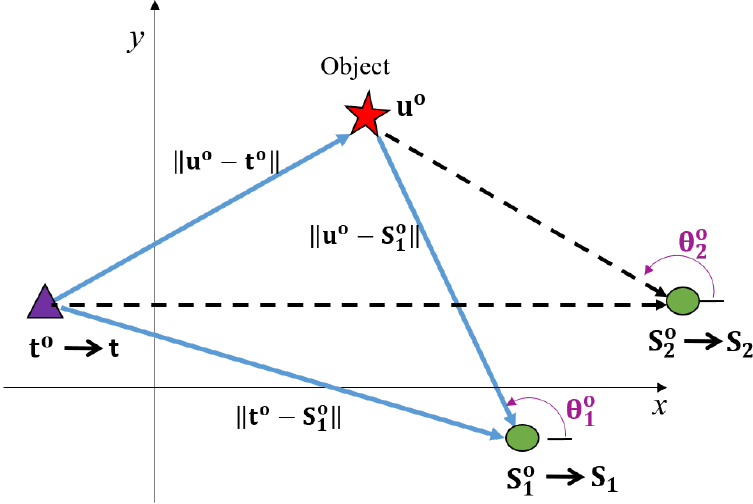
Figure 13. Scenario of multi-static sonar, a transmitter, and the object